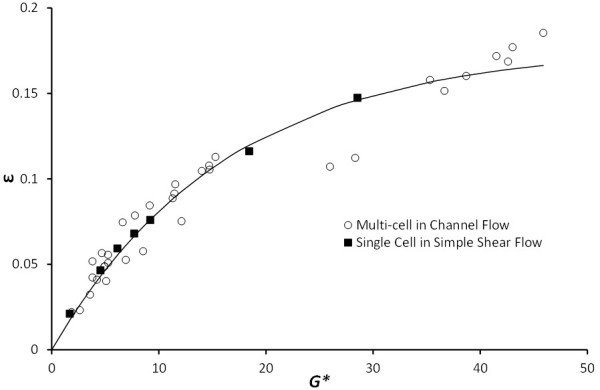
Relation between cell circumferential strainεand the local dimensionless shear rateG*. A nonlinear regression fit of results for the single cell in simple shear flow and multi-cells in channel flow indicates the validity of the ε and G* characterizations for general shearing conditions on the 2D RBC profile ε=−0.1771e−0.0611G*+0.1771;RSingle2=0.996andRMulti2=0.939.